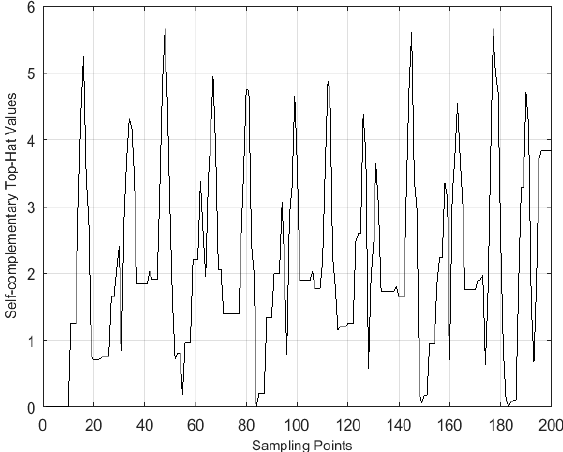
Figure 4. Results of self-complementary Top-Hat transform for the noisy signal.